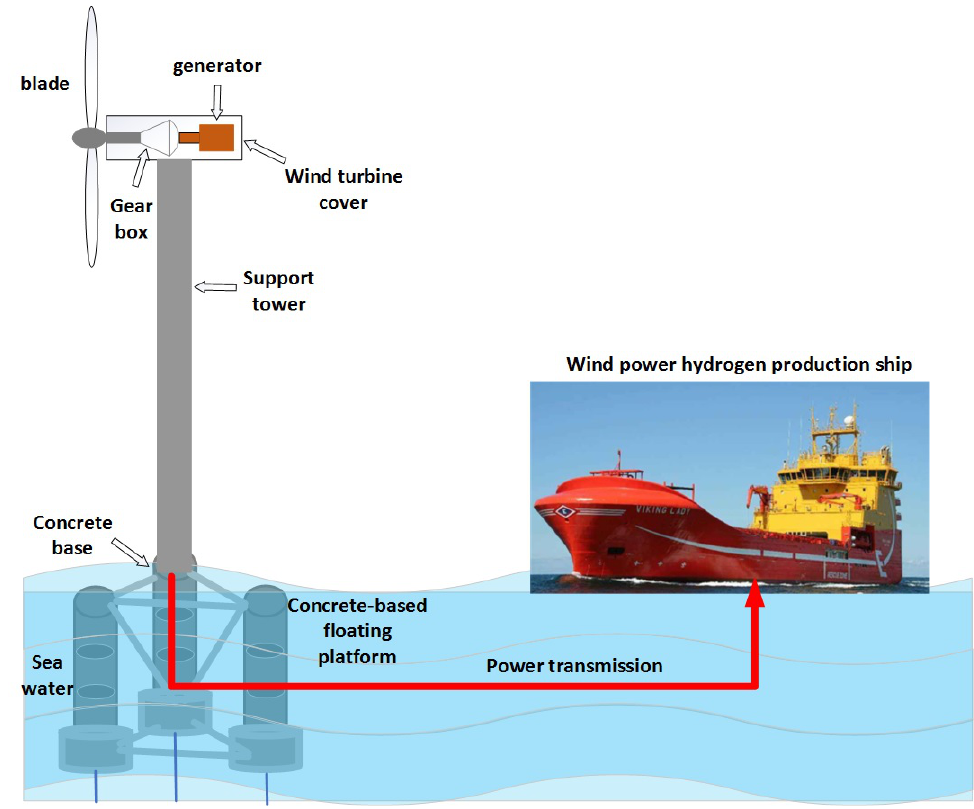
Figure 1. The description of floating offshore wind turbines and power to